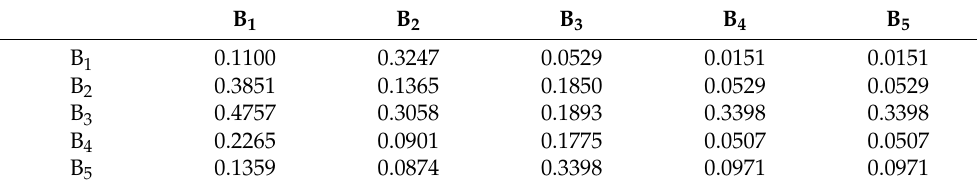
Table A4. The total influence matrix of the criteria (T B ).